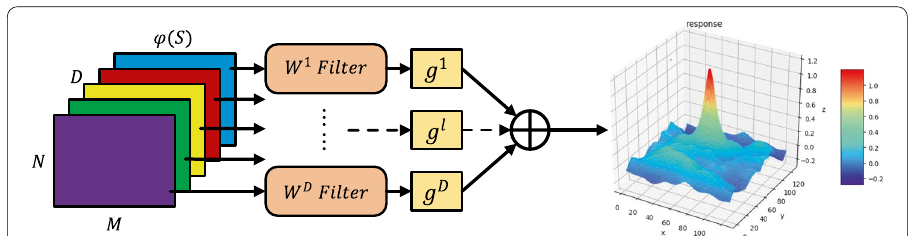
Fig. 3 Intuitive diagram of multi-channel correlation filter tracking based on deep feature